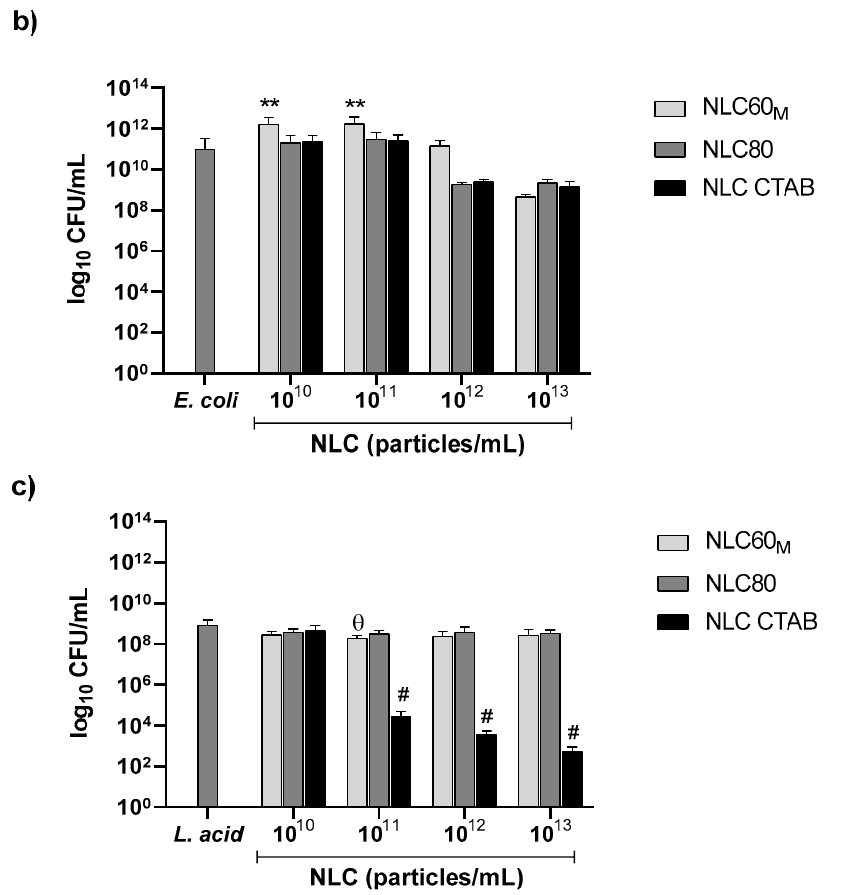
Figure 4. Antibacterial performance of increasing concentrations of NLC60 M , NLC80 and NLC CTAB against ( a ) H. pylori J99, ( b ) E. coli ATCC ® 25922™ and ( c ) L. acidophilus -01. Assays were performed over 24 h in MHB + 10% FBS medium. Data are expressed as means ± standard deviation. Statistical analysis was performed against the control (bacteria without NLC) using Tukey’s multiple comparisons test. ( a ) * All NLC formulations ( p < 0.001); ( b ) ** NLC60 M ( p < 0.01); ( c ) θ NLC60 M ( p < 0.05) and # NLC CTAB ( p < 0.05).